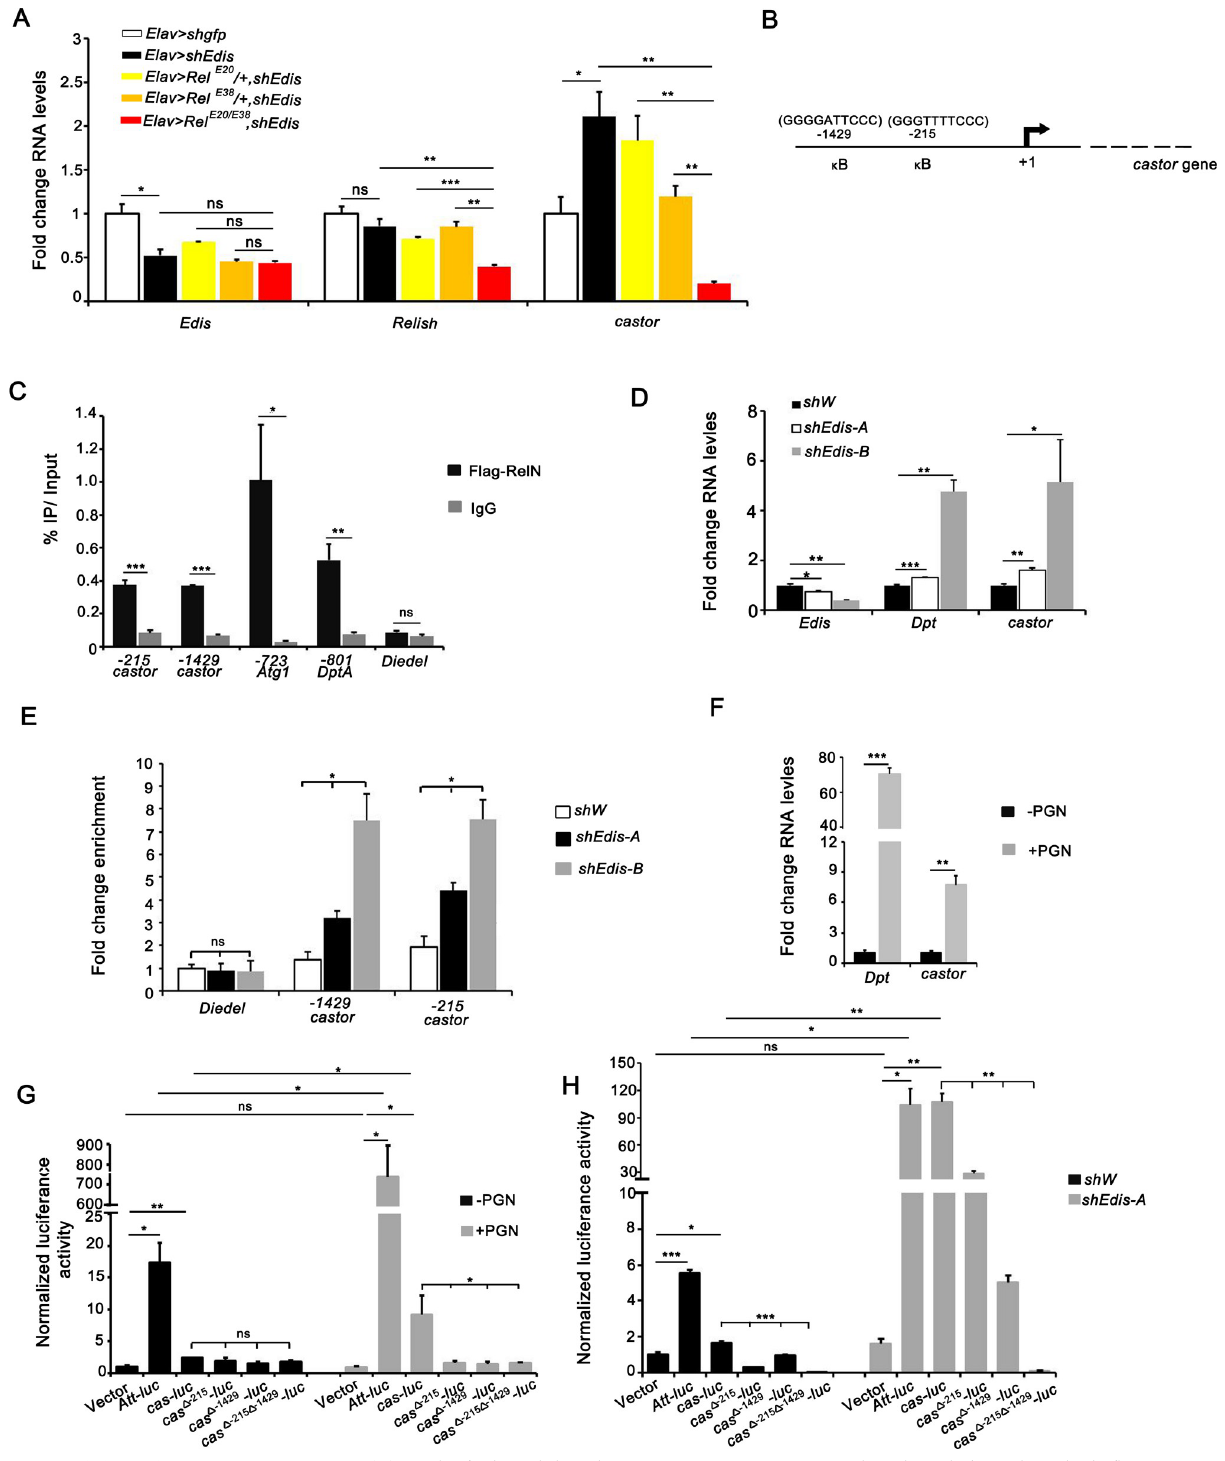
Fig 6. Relish regulates castor transcription. ( A ) Levels of Edis , Relish , and castor transcripts were measured in Elav > shgfp or Elav > shEdis flies in wildtype, Relish heterozygous ( Rel E20 /+ or Rel E38 /+ ) or homozygous ( Rel E20/E38 ) mutant background (n = 3). Levels of castor mRNA in Elav > shEdis flies are significantly lower in Relish homozygous ( Rel E20/E38 ) compared with Relish heterozygous or wildtype background. ( B ) A diagram showing a pair of candidate Relish-binding sites on the castor promoter. ( C ) UAS-Flag-RelN was expressed in neurons using Elav-Gal4 . Chromatin immunoprecipitation (ChIP) was performed in adult brain samples using anti-Flag antibody or IgG (control). Purified DNA was analyzed by using primer pairs